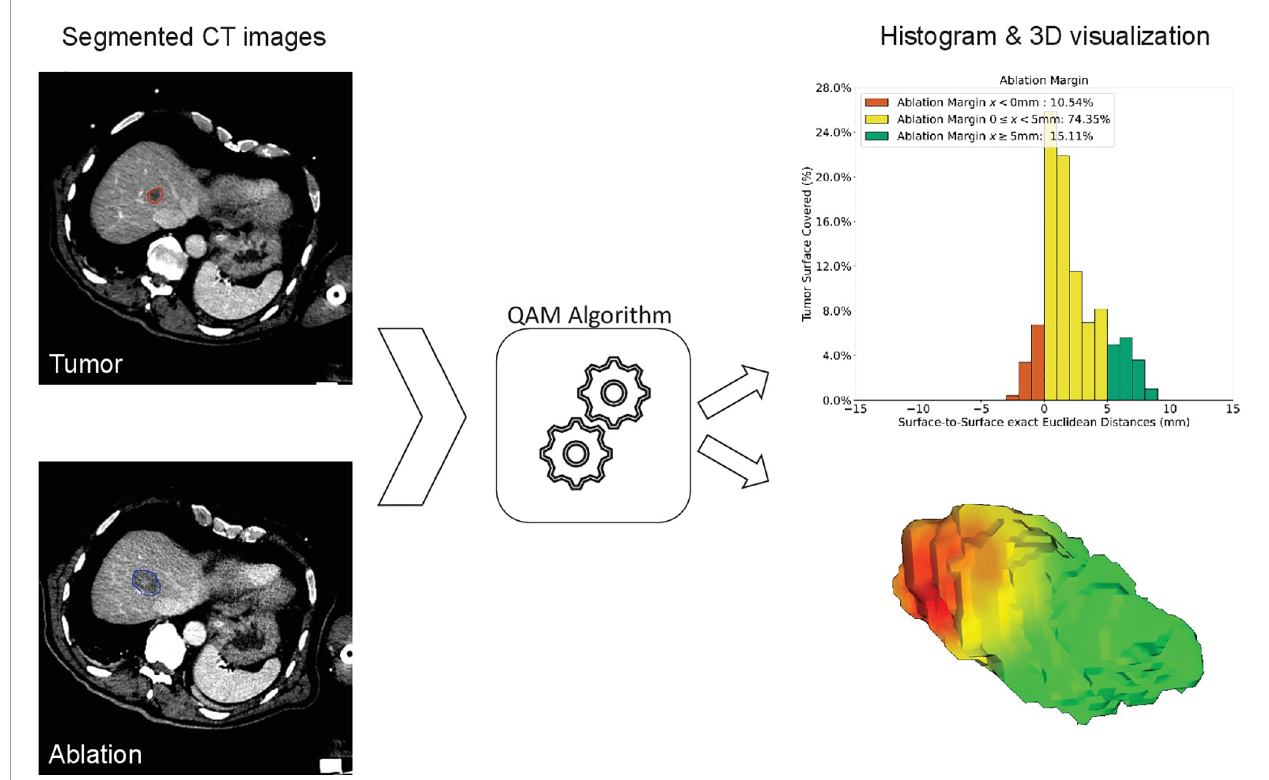
FIGURE 2 | Method of computation of three-dimensional quantitative ablation margin (3D-QAM). Left: segmentation of tumor (red) and ablation (blue) volumes. After calculating 3D-QAM, de fi ned as the distribution of tumor to ablation surface distance (32), the QAM output can be displayed as a histogram (upper right image) or as a 3D visualization of the ablation volume surface (lower right image). In the histogram, each bin represents the percentage of tumor surface covered by a speci fi c distance (e.g., 1 mm). Margins to the tumor surface of >5 mm are marked in green, of 0 – 5 mm in yellow, and of <0 mm (residual tumor) in red. In this example, 15.11% of the tumor surface was covered by an ablation zone of at least 5 mm